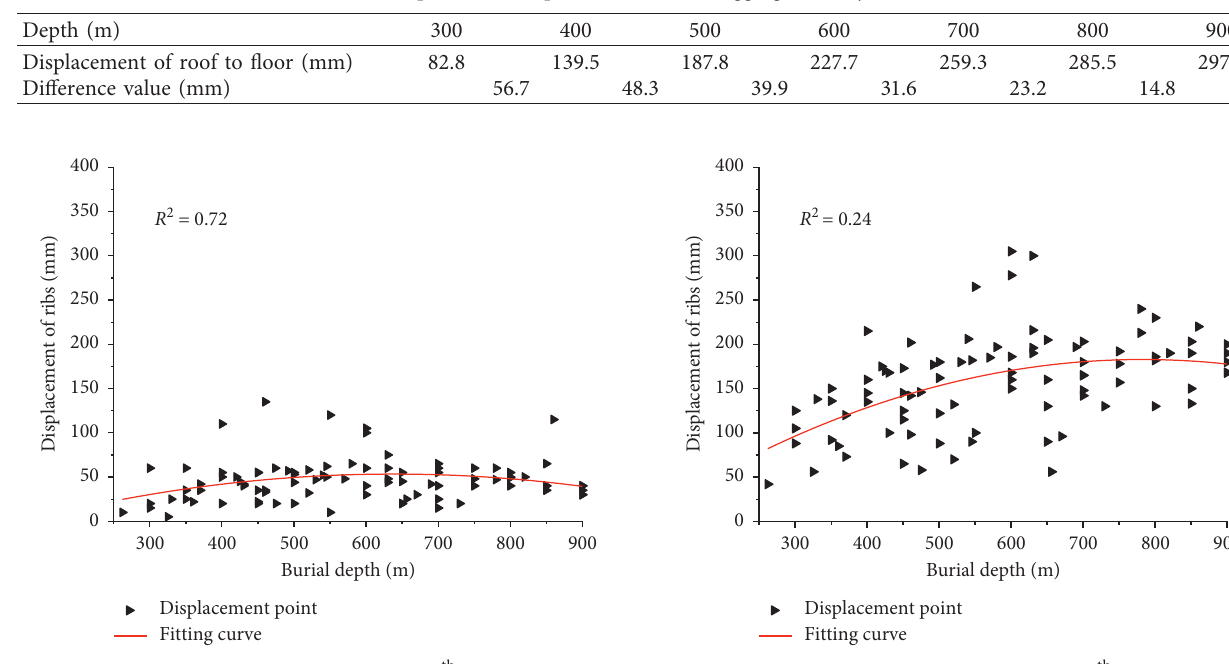
Figure 9: Displacement of ribs (5 th day).